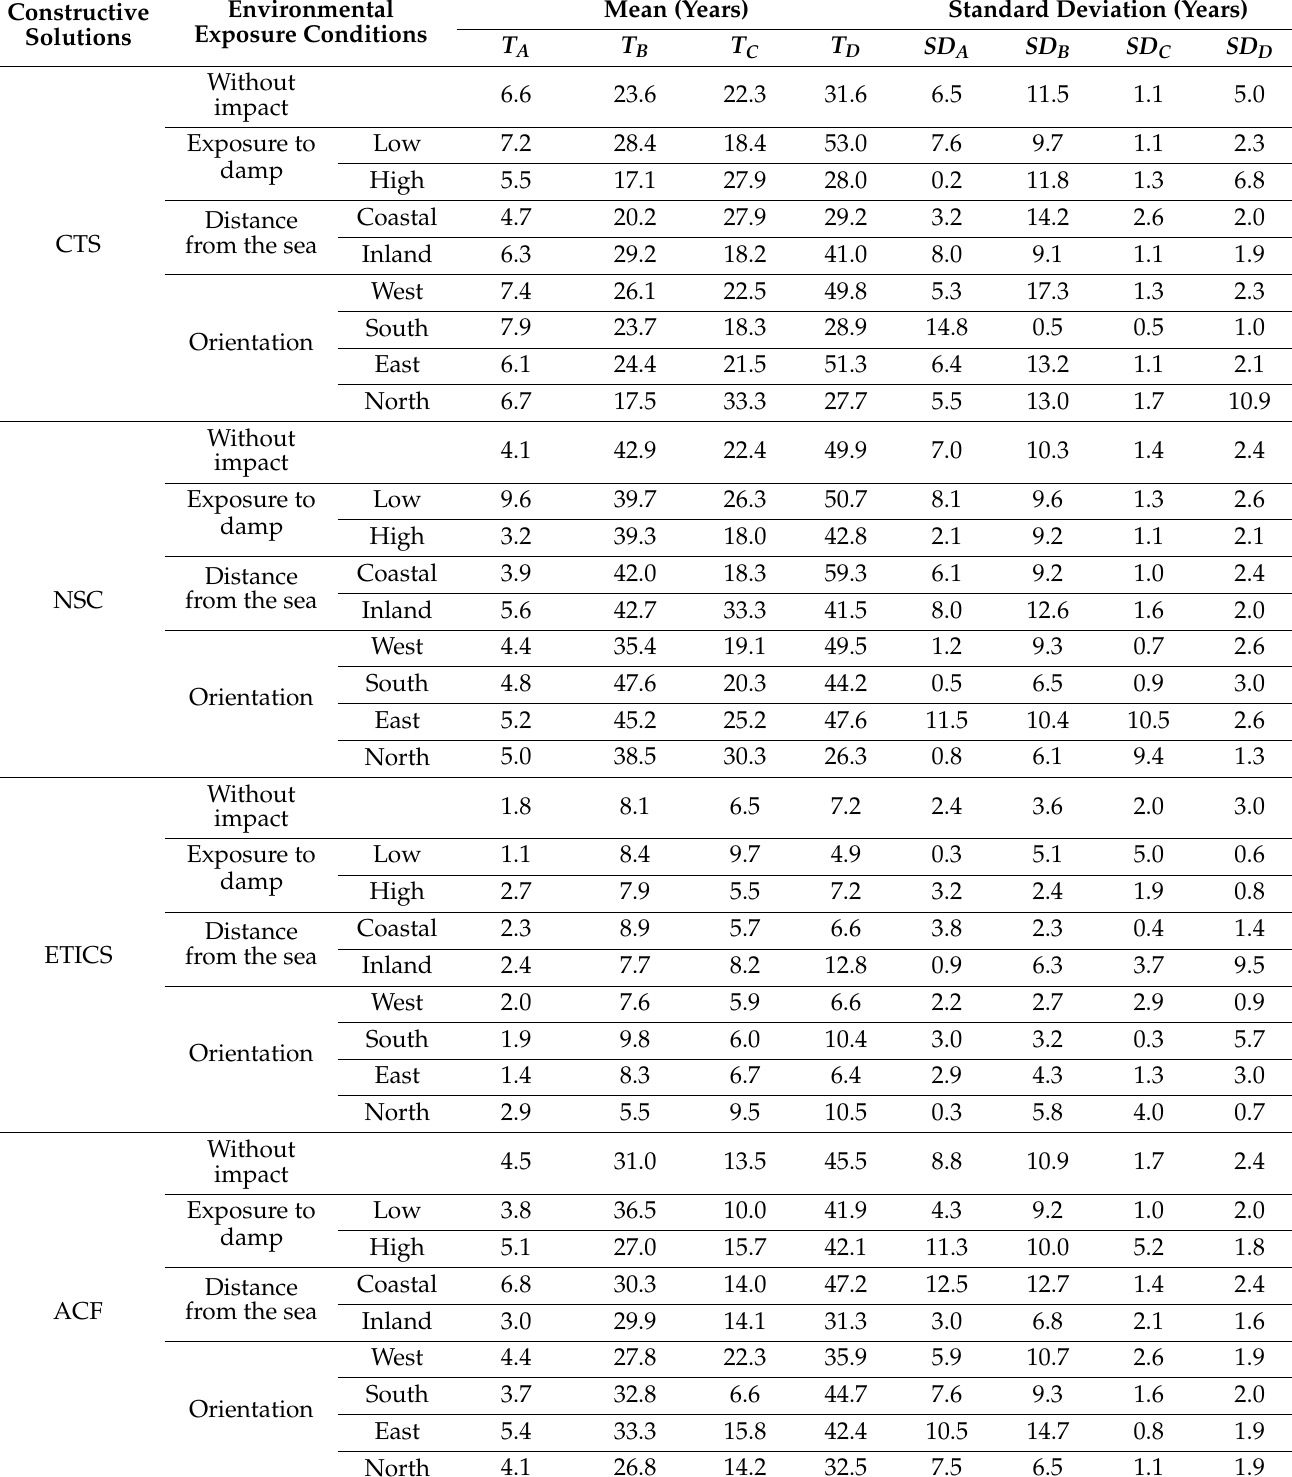
Table 1. Optimal parameters of the degradation process according to the environmental exposure conditions and the constructive